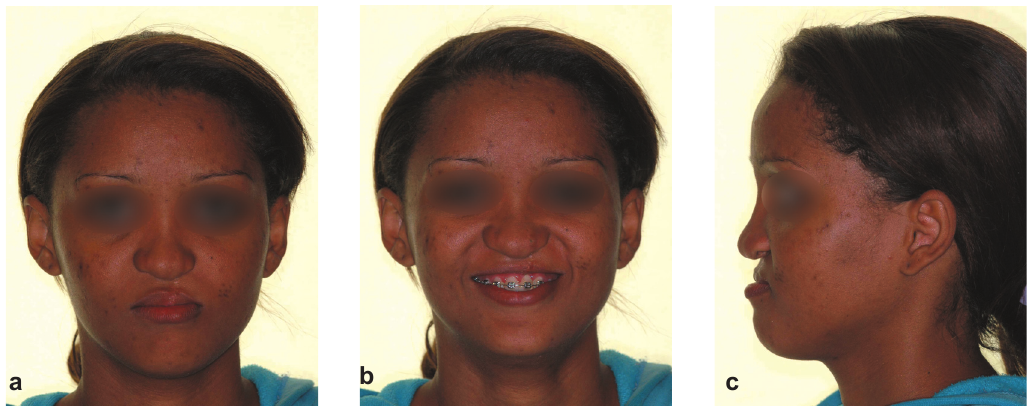
Figure 8- Preoperative photographs of a patient with complete unilateral cleft lip and palate treated with orthognatic surgery (a) Front preoperative photograph; (b) Smile preoperative photograph and (c) Profile preoperative photograph